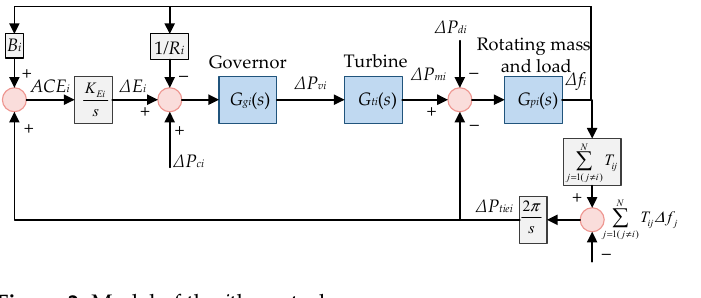
Figure 2. Model of the i th control area.